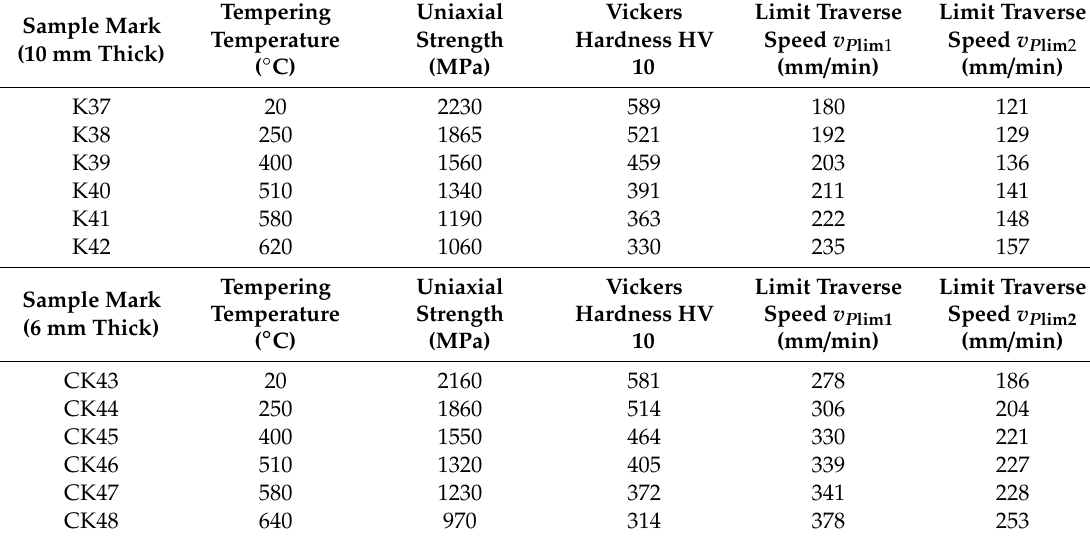
Table 2. Steel 34CrMo4 samples austenitized at 850 ◦ C, quenched in polymer and tempered at various presented temperatures.